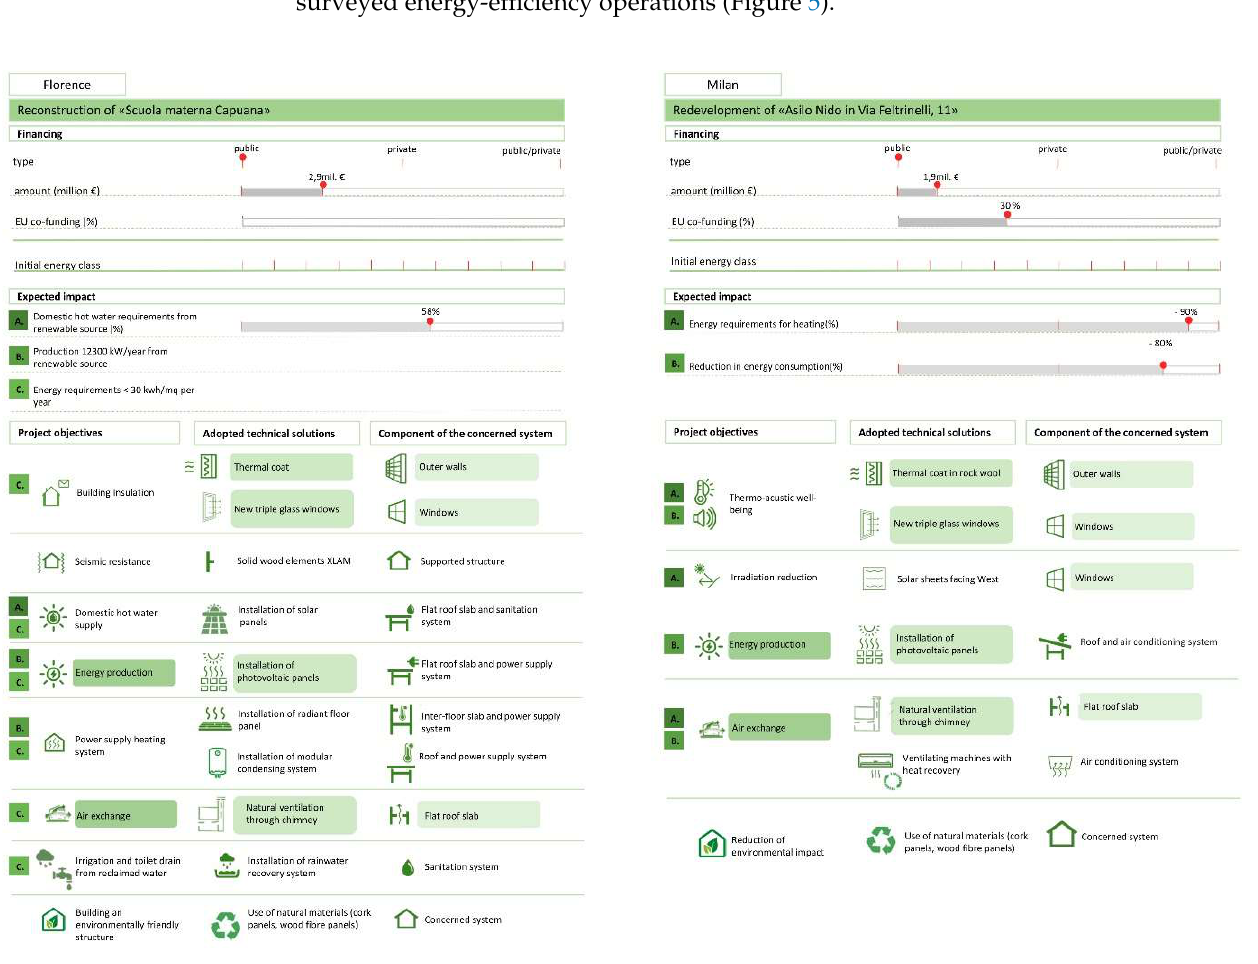
Figure 5. Milan and Florence case study: comparative analysis of technological